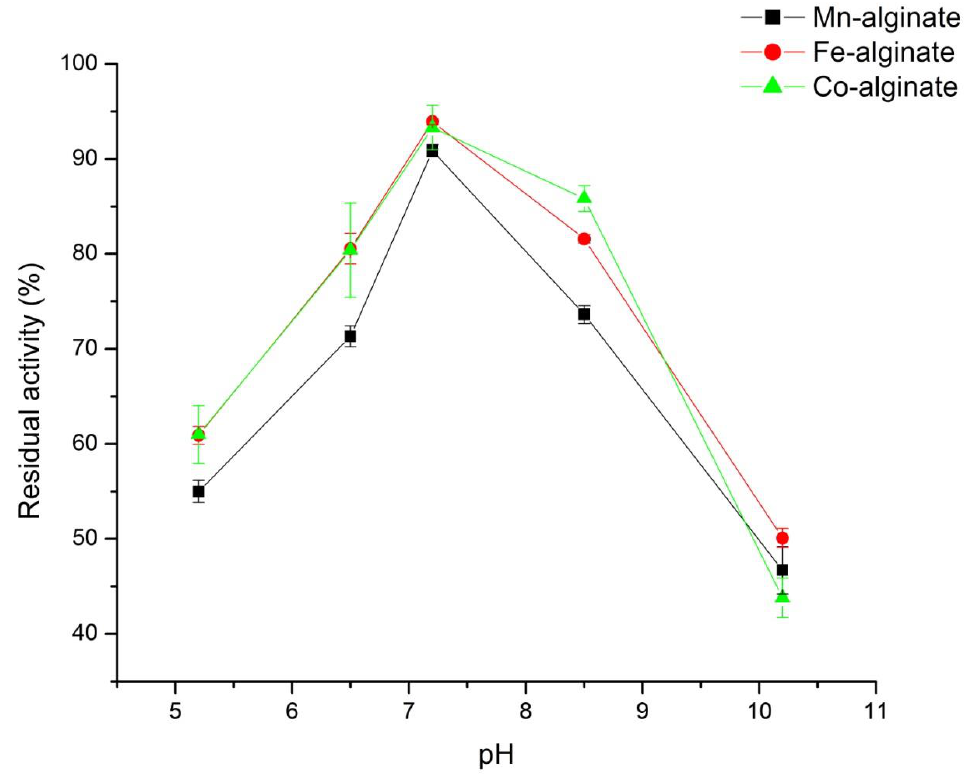
Figure 5. Variation of percent-relative activity with pH, studied for encapsulated urease enzyme in alginate nanogels cross-linked with Mn 2+ , Fe 3+ , and Co 2+ .